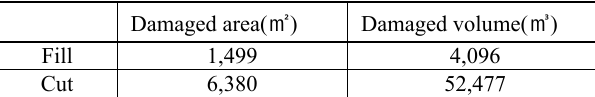
Table 3. Damage analysis